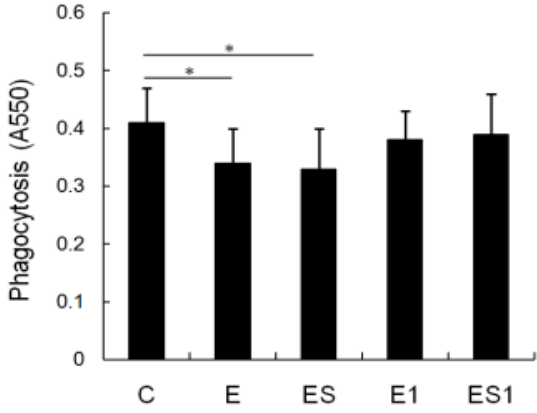
Figure 3. Effects of strenuous exercise and BCAA supplementation on the phagocytosis of MФs. MФs were incubated with 0.1% neutral red solution for 30 min, as described in “Materials and Methods”. The absorbance at a wavelength of 550 nm represented phagocytosis by macrophages. Data are means ± SD of A550 nm. * p < 0.05.